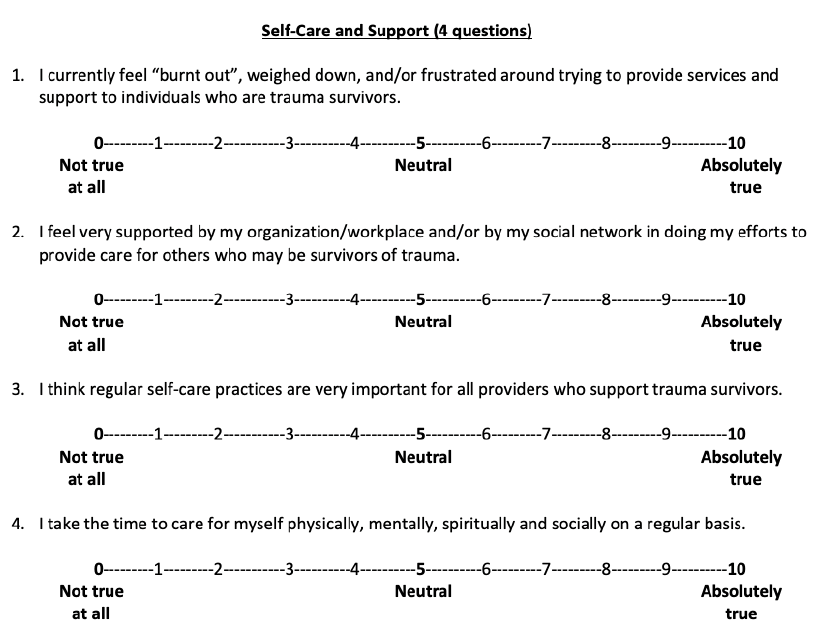
Figure 2. Self-care and support questionnaire items.